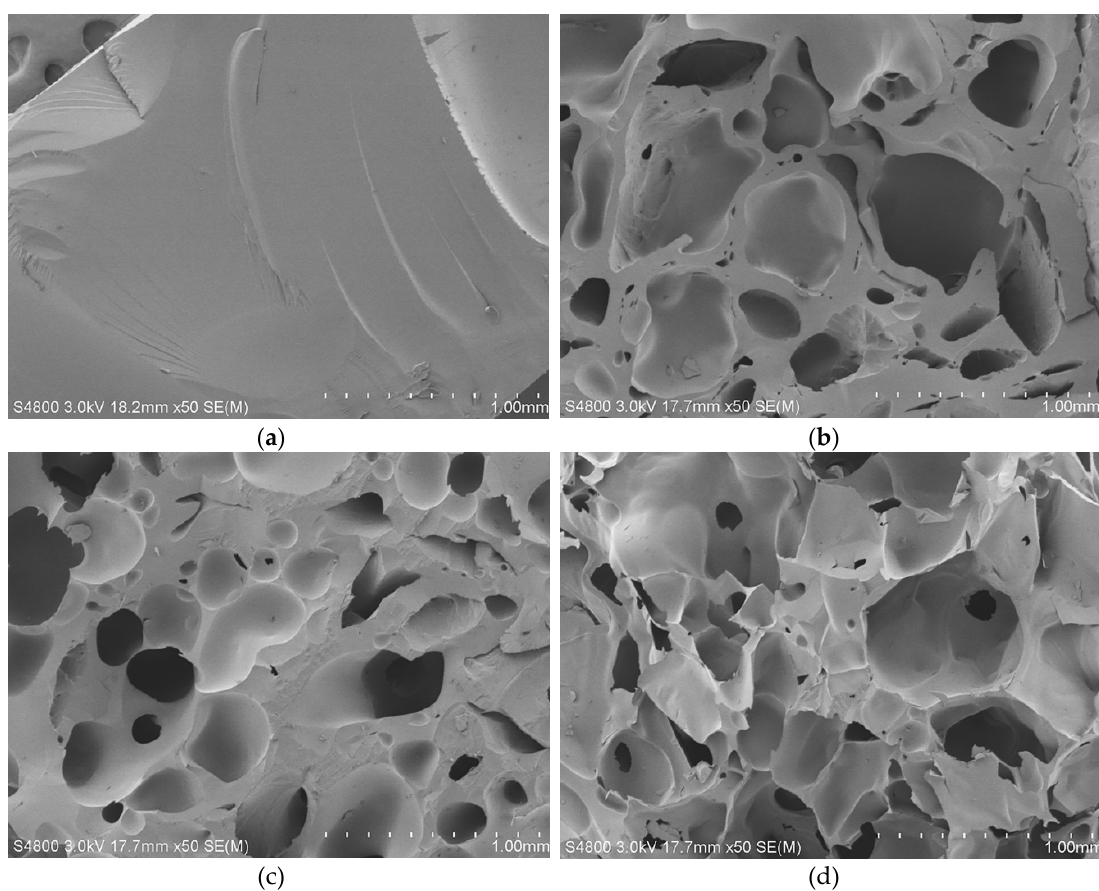
Figure 5. SEM images of ( a ) PAT–PAC-50, ( b ) c-PAT–PAC-70, ( c ) c-PAT–PAC-50, and ( d ) c-PAT–PAC-30.